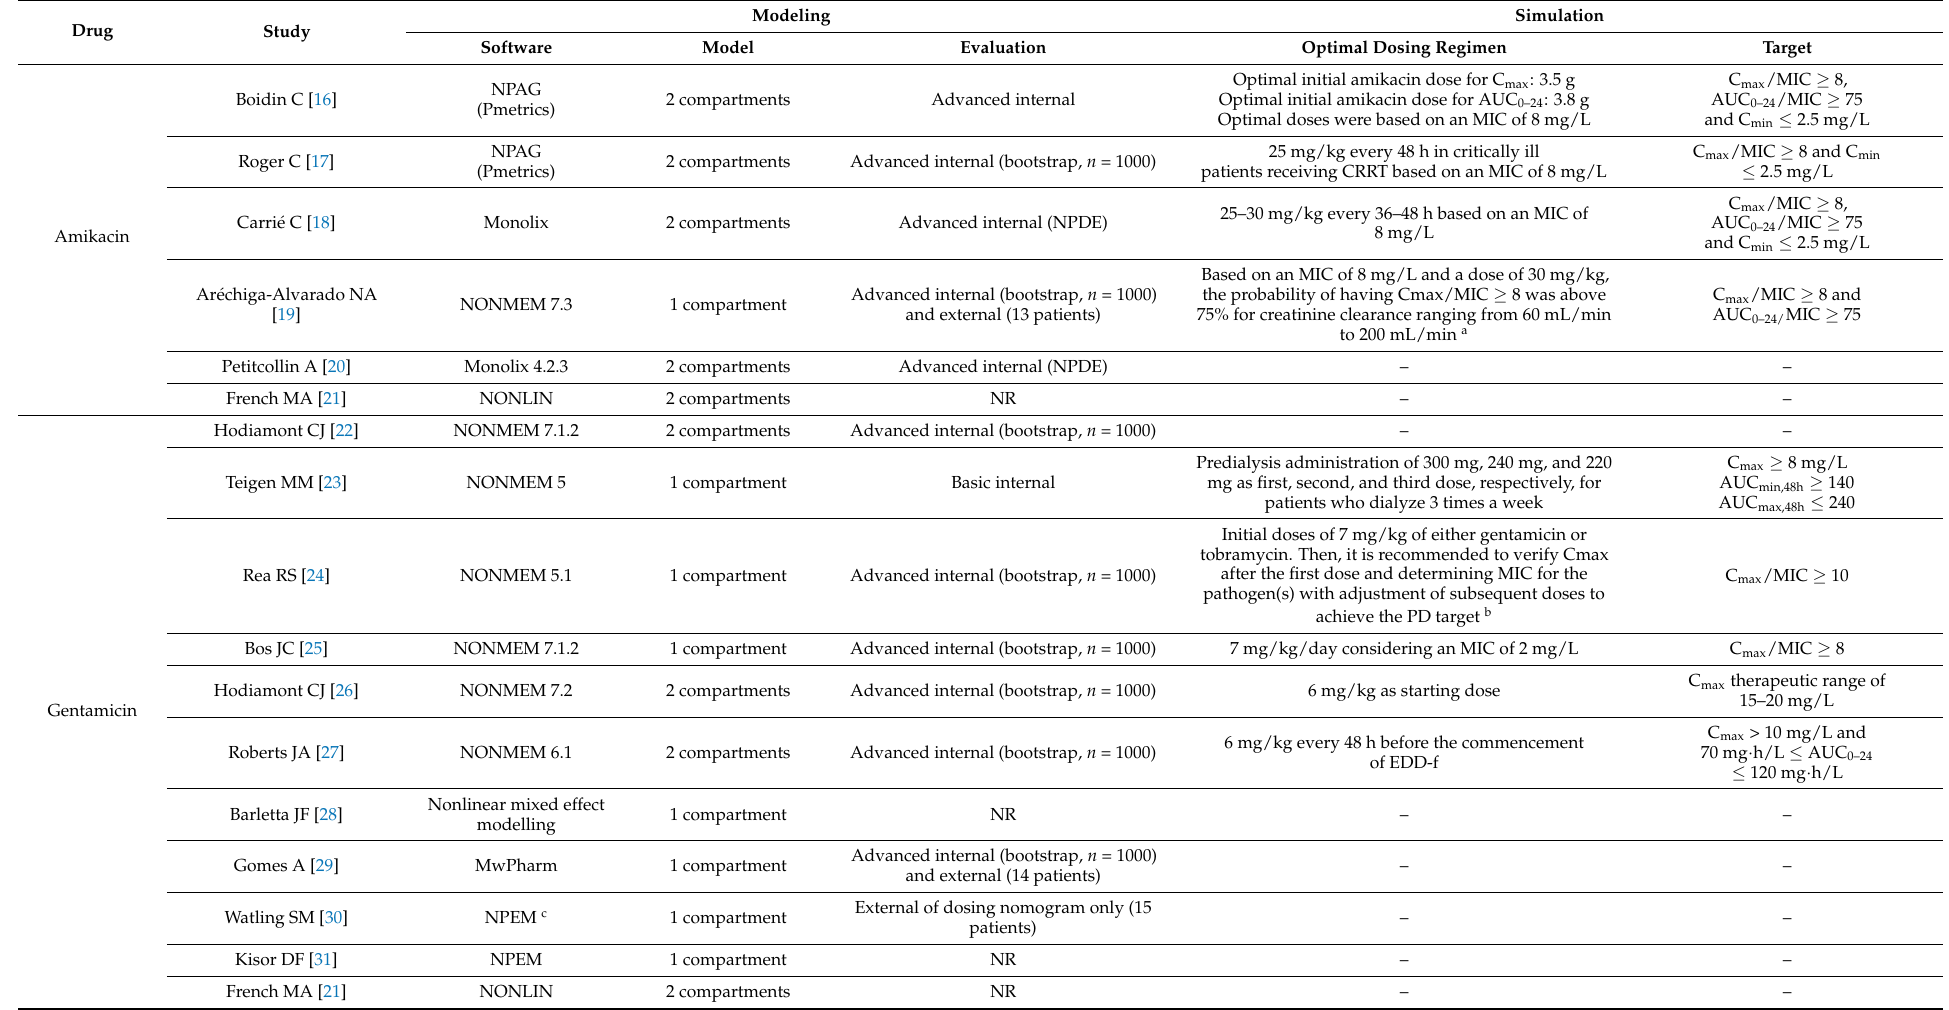
Table 2. Population pharmacokinetic modeling methods and techniques used by the studies included in the